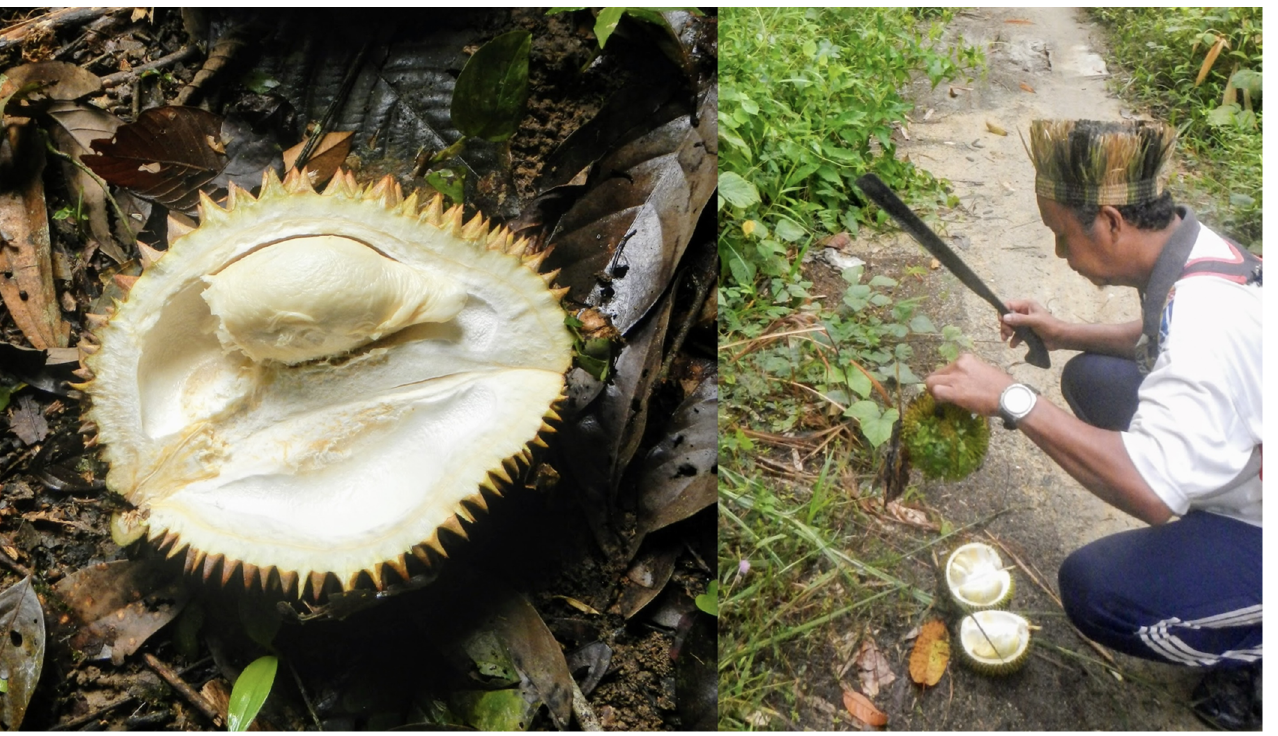
Figure 4. Durians ( Durio spp.) are sought-after by both elephants and people. Credit: T. Lim/MEME 2016.